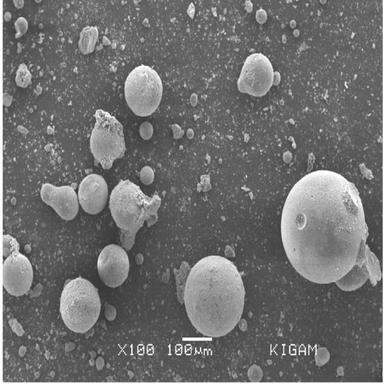
SEM micrograph of the IGCC slag sample. The smooth and spherical particle sizes varied over a broad range.